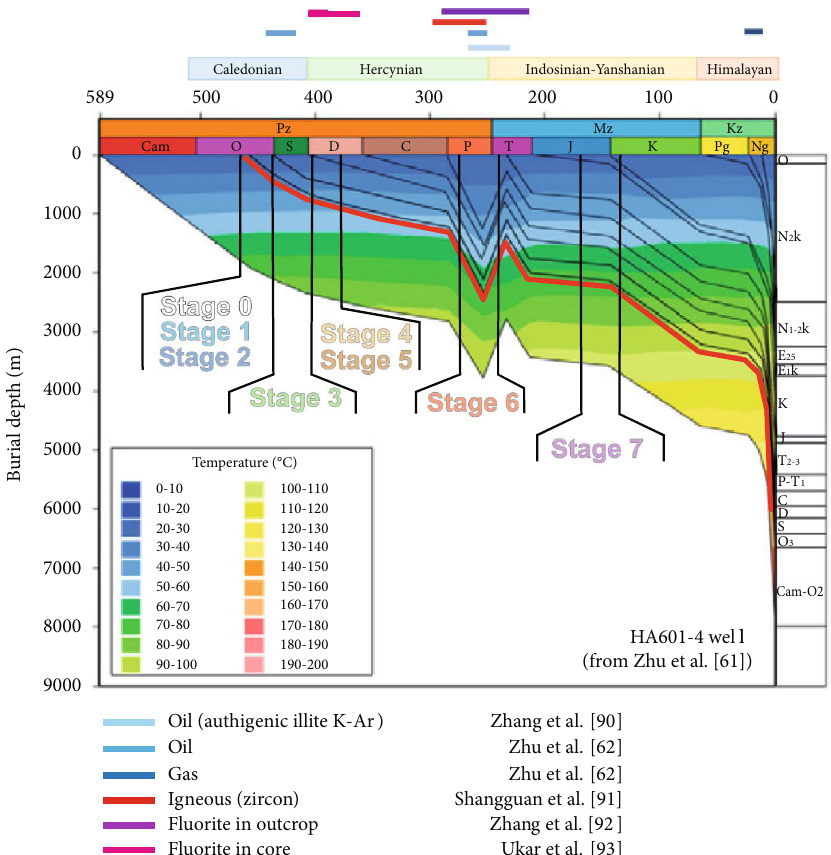
Figure 13: Estimated timing and depths of occurrence of the diagenetic stages described in the text in the context of a burial history model calculated for one of the wells in our study area (burial history curve from Zhu et al. [61]; well